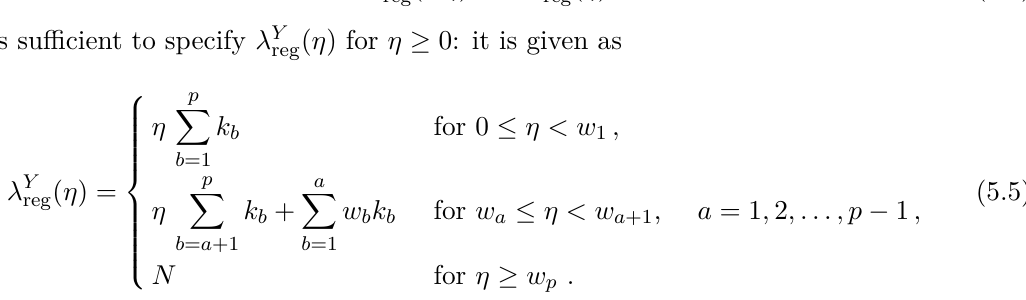
Figure 6. The total charge density λ ( η ) can be written as the sum of the contributions λ Y ( η ) . Both λ Y λ ( N,k ) irreg ( η ) on the semiaxis η ≥ 0 in the case N = 7 , p = 3 , w λ ( N,k ) irreg N + k = 11